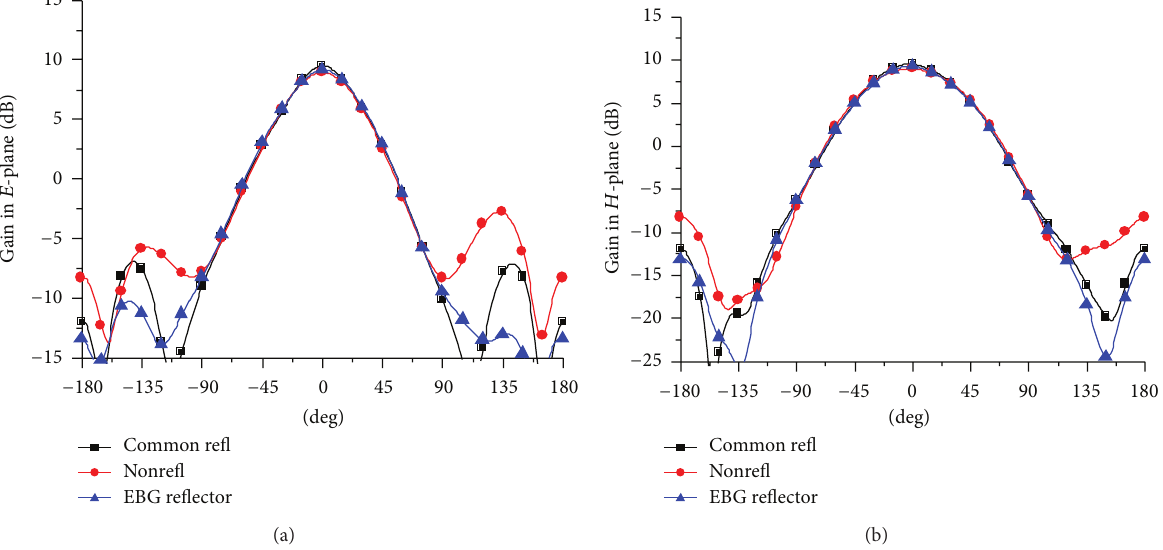
Figure 3: Element antenna radiation pattern with different reflector structures at 5.35 GHz.